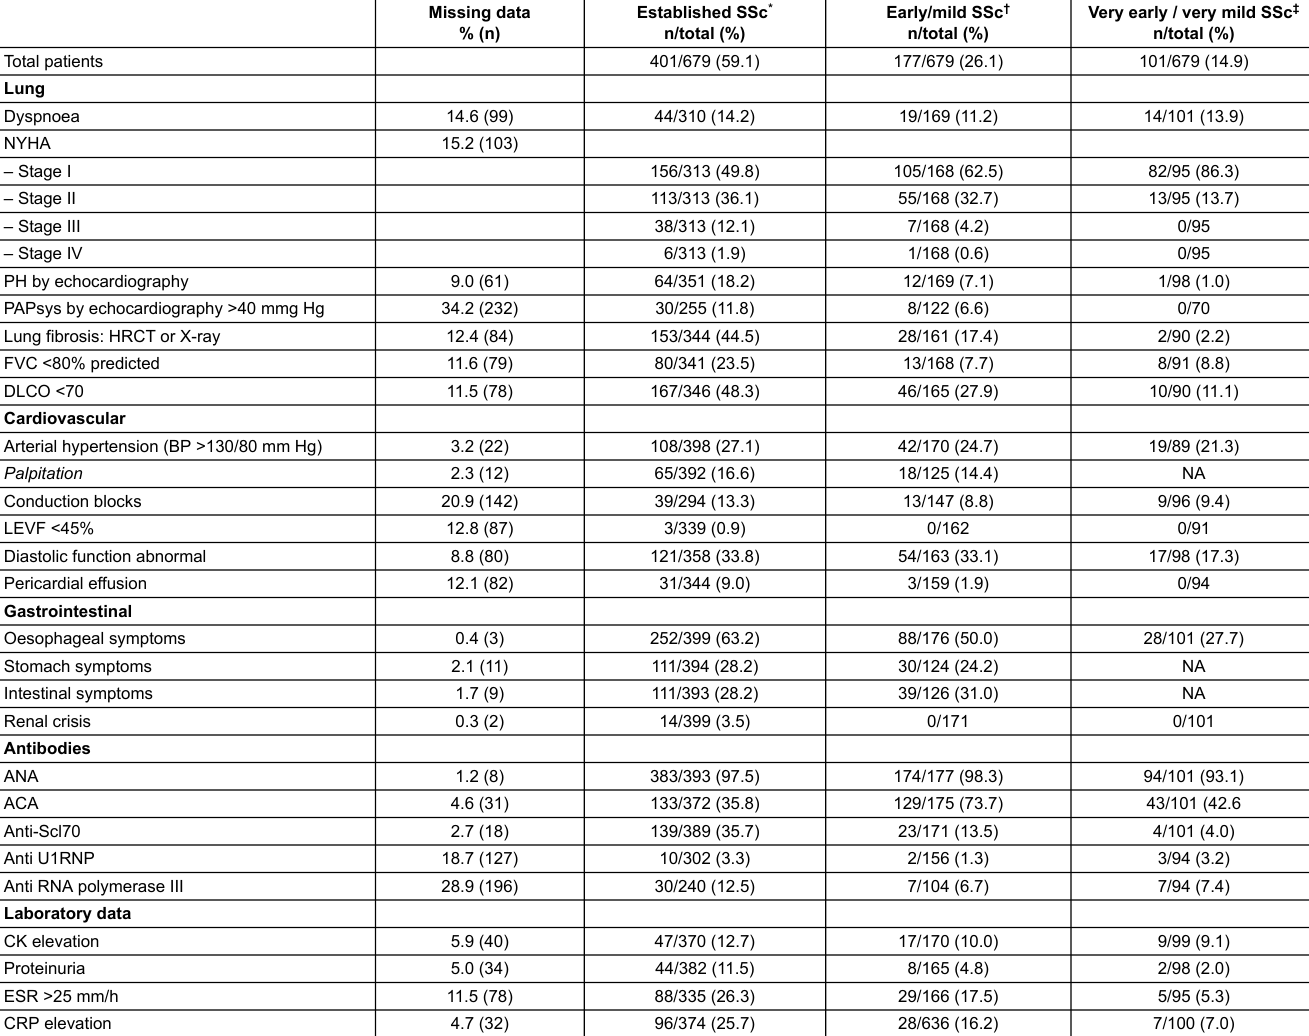
Table 2: Organ involvement, autoantibody profile and laboratory of Swiss SSc patients